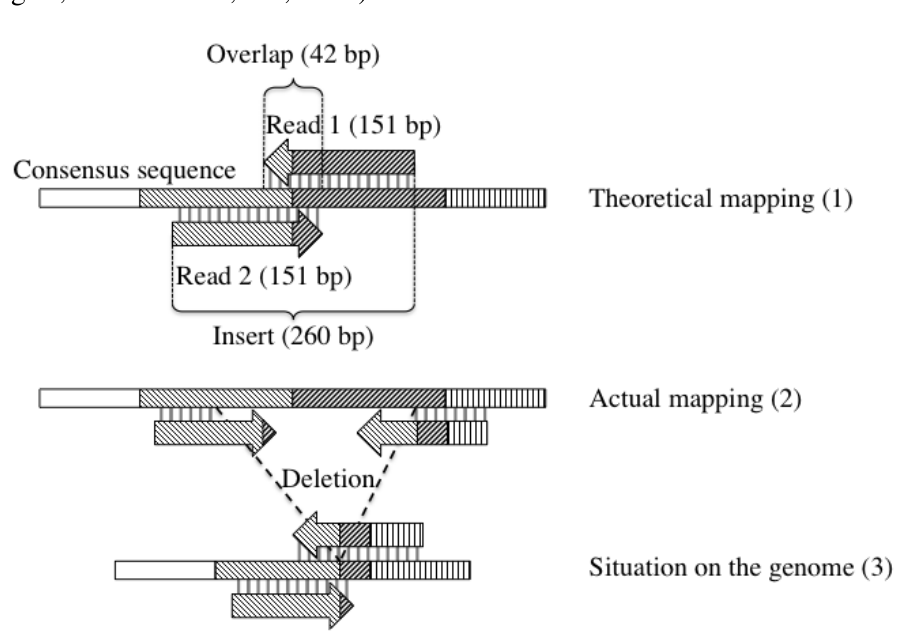
Figure 2. Strategy for finding large deletions. A genome consensus sequence section is shown along with the two pair reads associated with it and the position they map depending on the analyses conducted. Grey bars between reads and the consensus sequence represent a good alignment. ( 1 ) Read 1 and Read 2 represent paired-end reads, they should theoretically map on the consensus sequence with an overlap of about 42 bp as the insert is 260 bp long; ( 2 ) The actual mapping with a larger distance between reads of a pair and/or a poor mapping of the end of the reads can differ from expectation based on the consensus; ( 3 ) This different mapping happens because the genome from which the reads were produced carried a deletion.